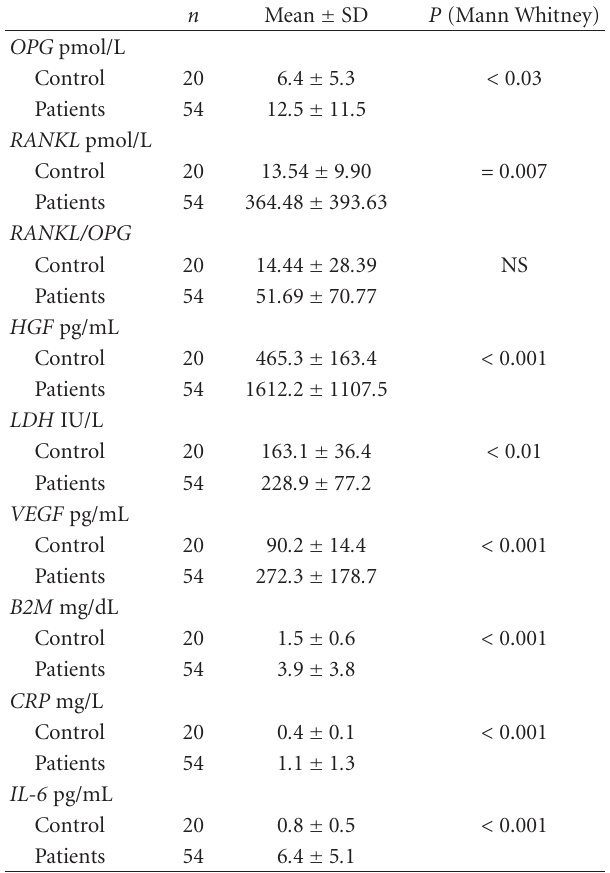
Table 1: Serum concentrations of measured parameters in healthy controls and patients with multiple